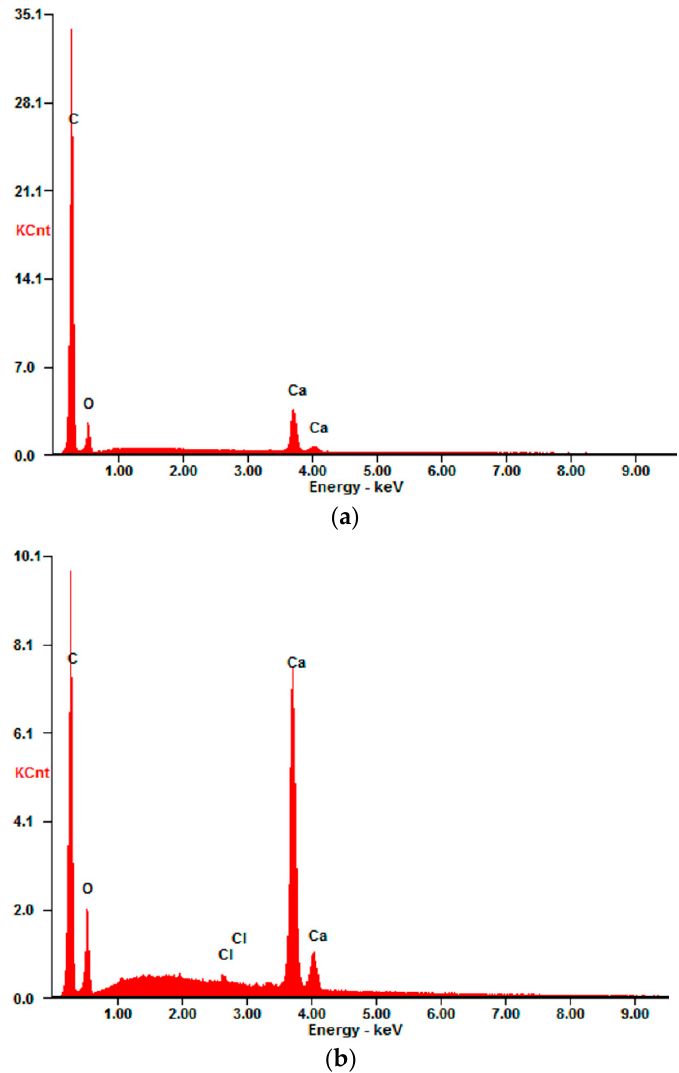
Figure 14: EDX analysis in the marked area 1 ( a ) and EDX analysis in the marked area 2 ( b ).